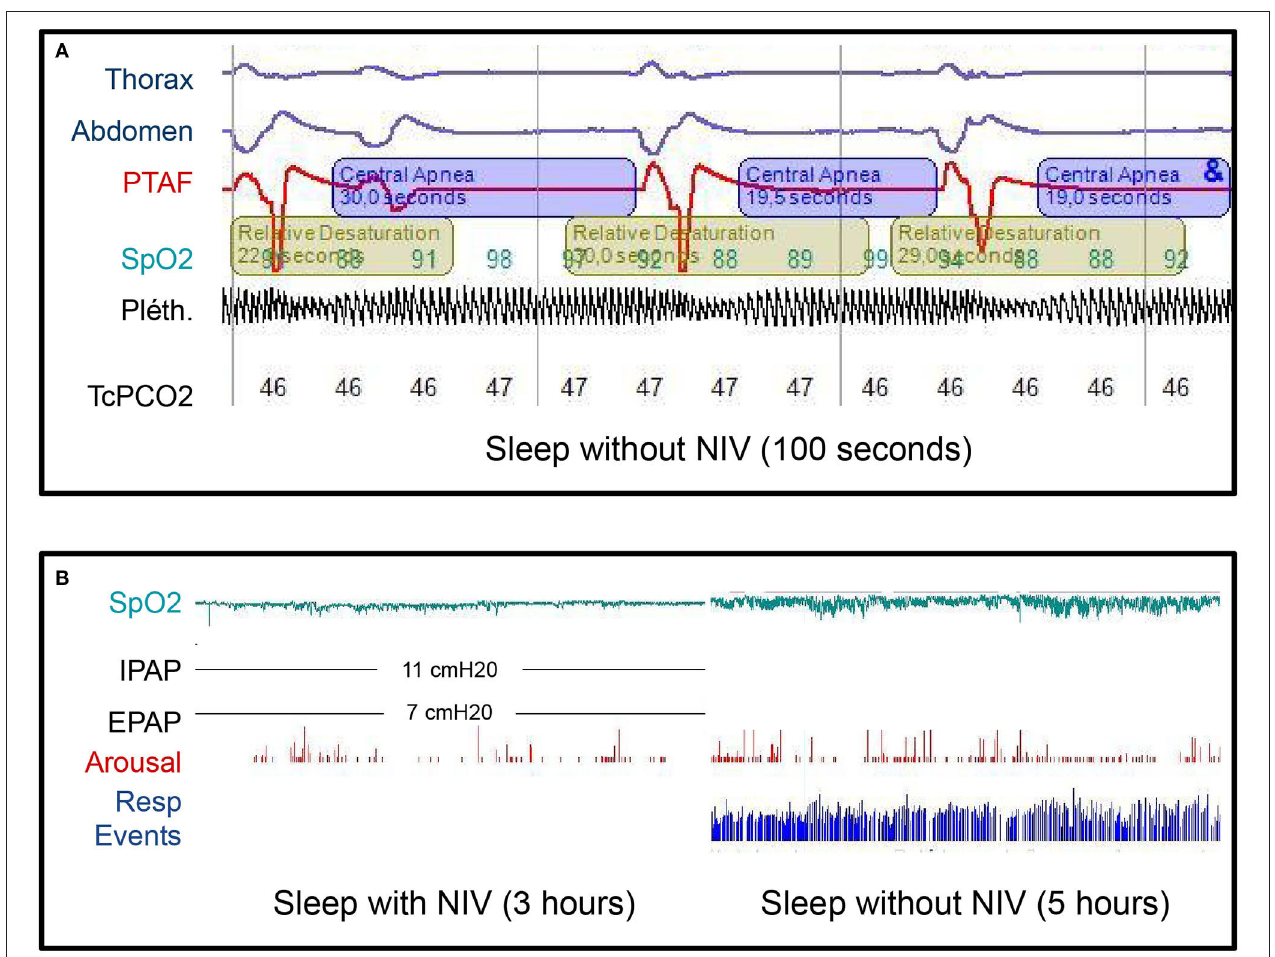
FIGURE 3 | (A) Diagnostic sleep study without noninvasive ventilation (NIV) at day 34 after admission. Note three central apnea (cessation of airflow associated with the absence of respiratory efforts and therefore no thoracic or abdominal movements) with subsequent hypoxemia. The apnea-hypopnea index in this study was 110/h. The mean respiratory rate was 3/min. THO, thoracic belt signal; ABD, abdominal belt signal; PTAF, pressure transducer airflow; SpO2, saturation measured by pulse oximetry; Pléth., plethysmography waveform derived from the pulse oximeter; TcPCO 2 , transcutaneous carbon dioxide monitoring. (B) Diagnostic sleep study with and without NIV, 3 years after the diagnosis. No respiratory events occurred during the first part of the night with NIV and the SpO2 was above 90% all the time. During the second part of the night without NIV, the apnea-hypopnea index was 110/h and the SpO2 dropped below 90% for 29min over 5h with minimal SpO2 of 80%. No recovery of the central sleep apnea syndrome occurred between those two sleep studies. IPAP, inspiratory airway pressure; EPAP, expiratory airway pressure; cmH 2 O, centimeters of water; Resp events, Respiratory